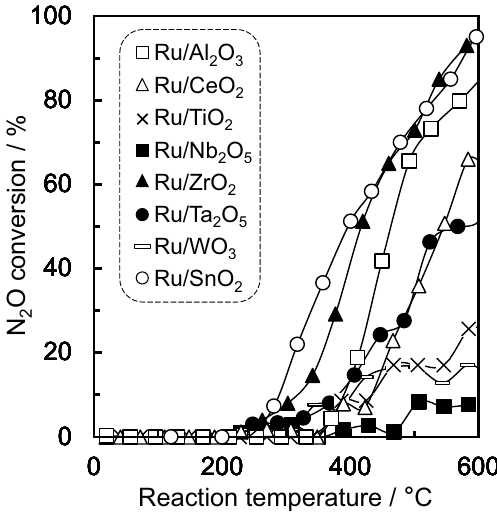
Figure 2. Catalytic activity for N 2 O decomposition reaction over 5.0 wt% Ru supported on various different metal oxide materials. Reaction conditions: 200 ppm of N 2 O, 10% O 2 and N 2 balance at 100 cm 3 min −1 (W/F = 5.0 × 10 −4 g·min cm −3 ).